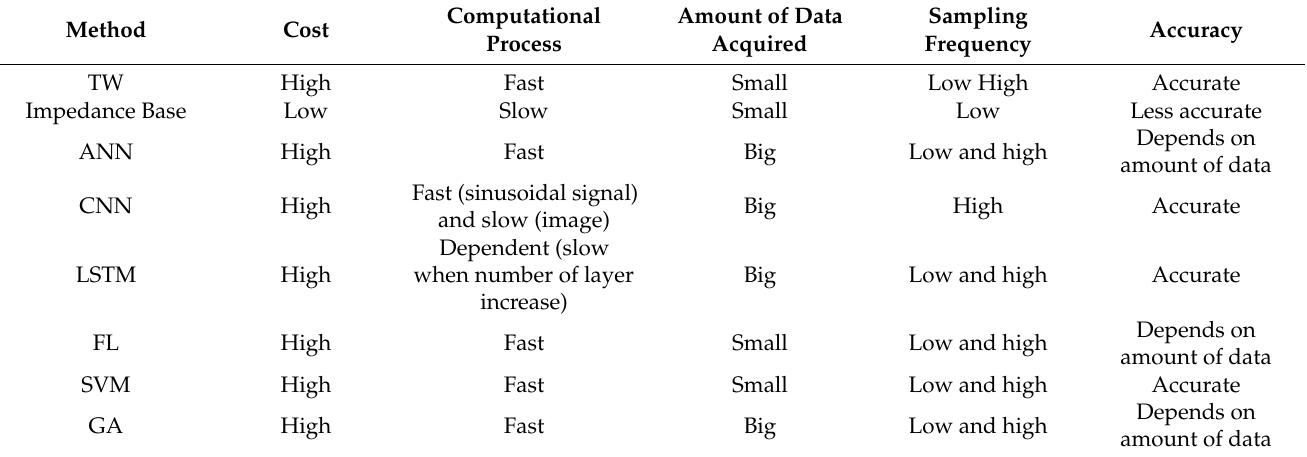
Table 7. Summary of advantages and disadvantages of methods.